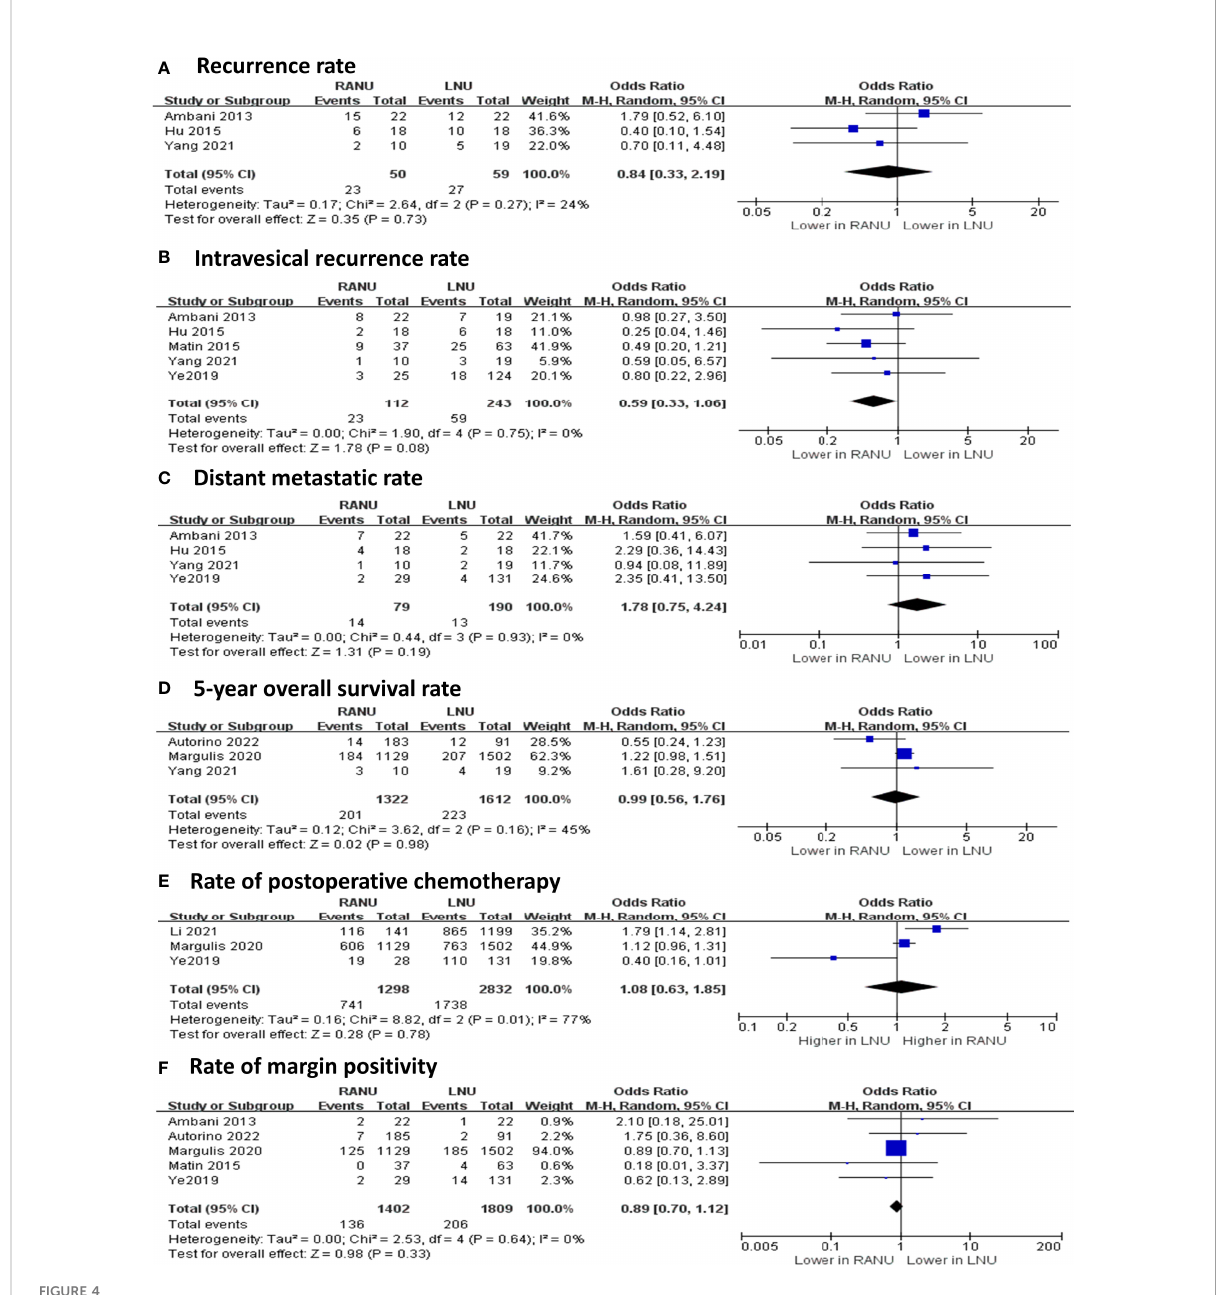
FIGURE 4 Forest plots of oncologic outcomes including recurrence rate (A) , intravesical recurrence rate (B) , distant metastatic rate (C) , 5-year overall survival rate (D) , rate of postoperative chemotherapy (E) and rate of margin positivity (F) for robotic-assisted nephroureterectomy (RANU) versus laparoscopic nephroureterectomy